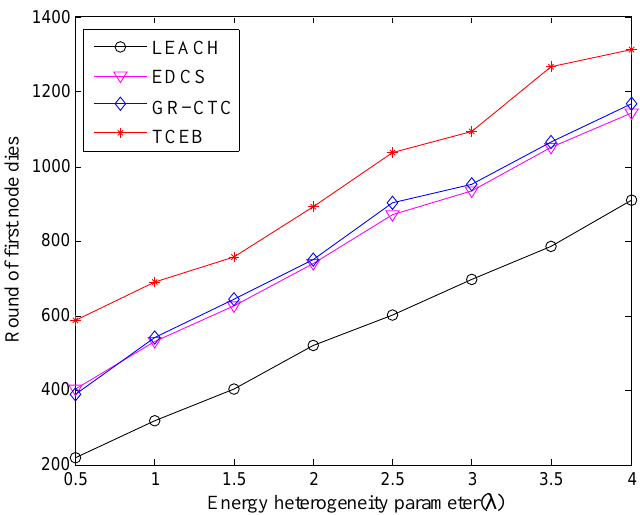
Figure 7. The comparison of stable period under different energy heterogeneity factor ( n = 100 ) .